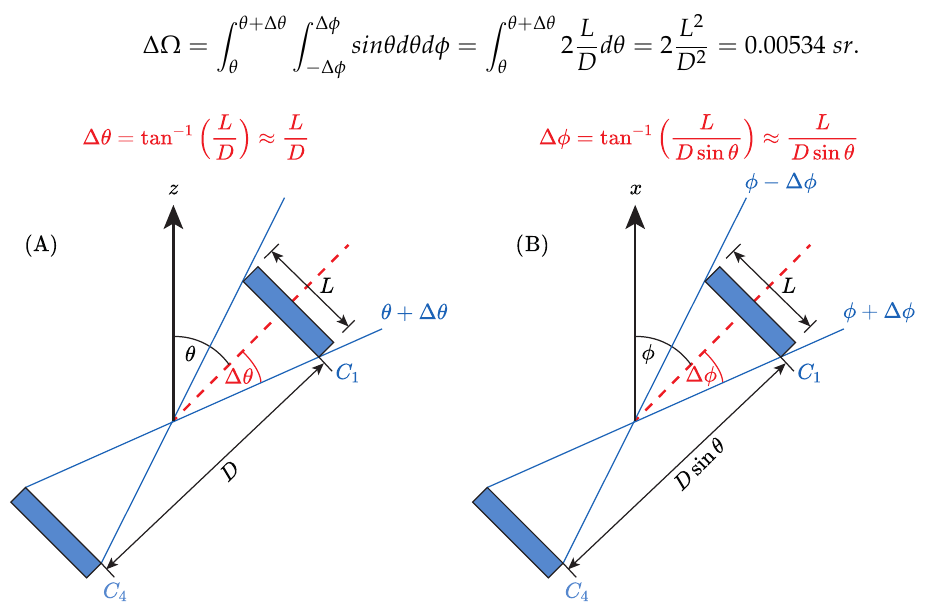
Figure 2. ( A ) Longitudinal view and ( B ) lateral view of the two farthest detectors of the